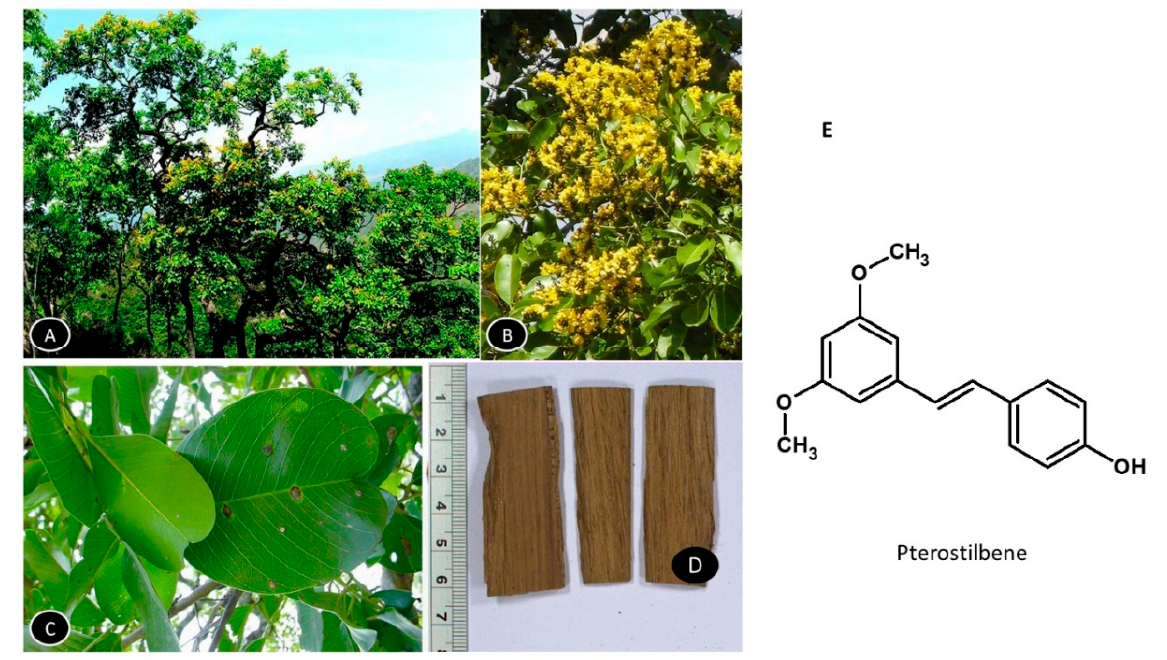
Figure 8. Pterocarpus marsupium . ( A ) Habitat of the plant; ( B ) A portion of shoot showing inflorescence and flowers; ( C ) Enlarged view of leaves; ( D ) Wood slices and major actives, ( E ) Pterostilbene.